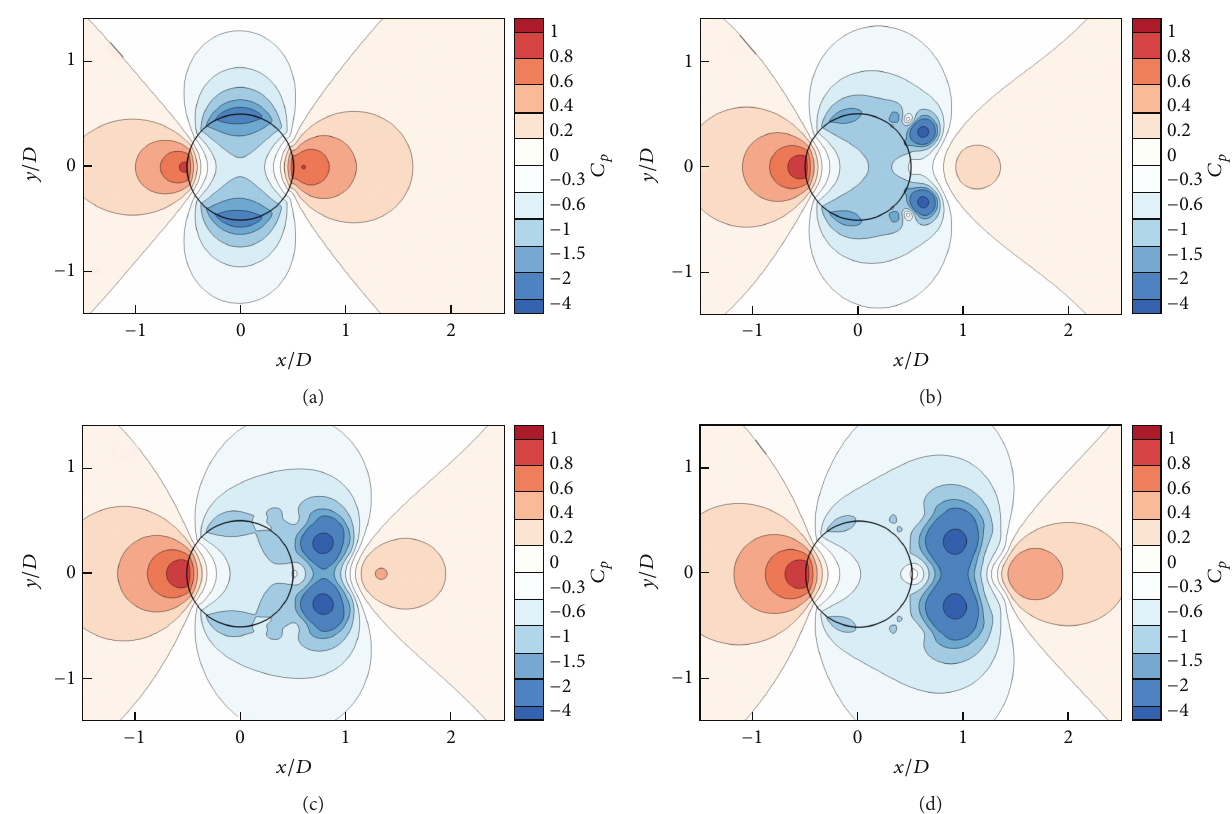
Figure 8: Pressure coefficient distribution around a circular cylinder for Re = 3000 : (a) 𝑇 = 1 , (b) 𝑇 = 3 , (c) 𝑇 = 5 , and (d) 𝑇 = 7